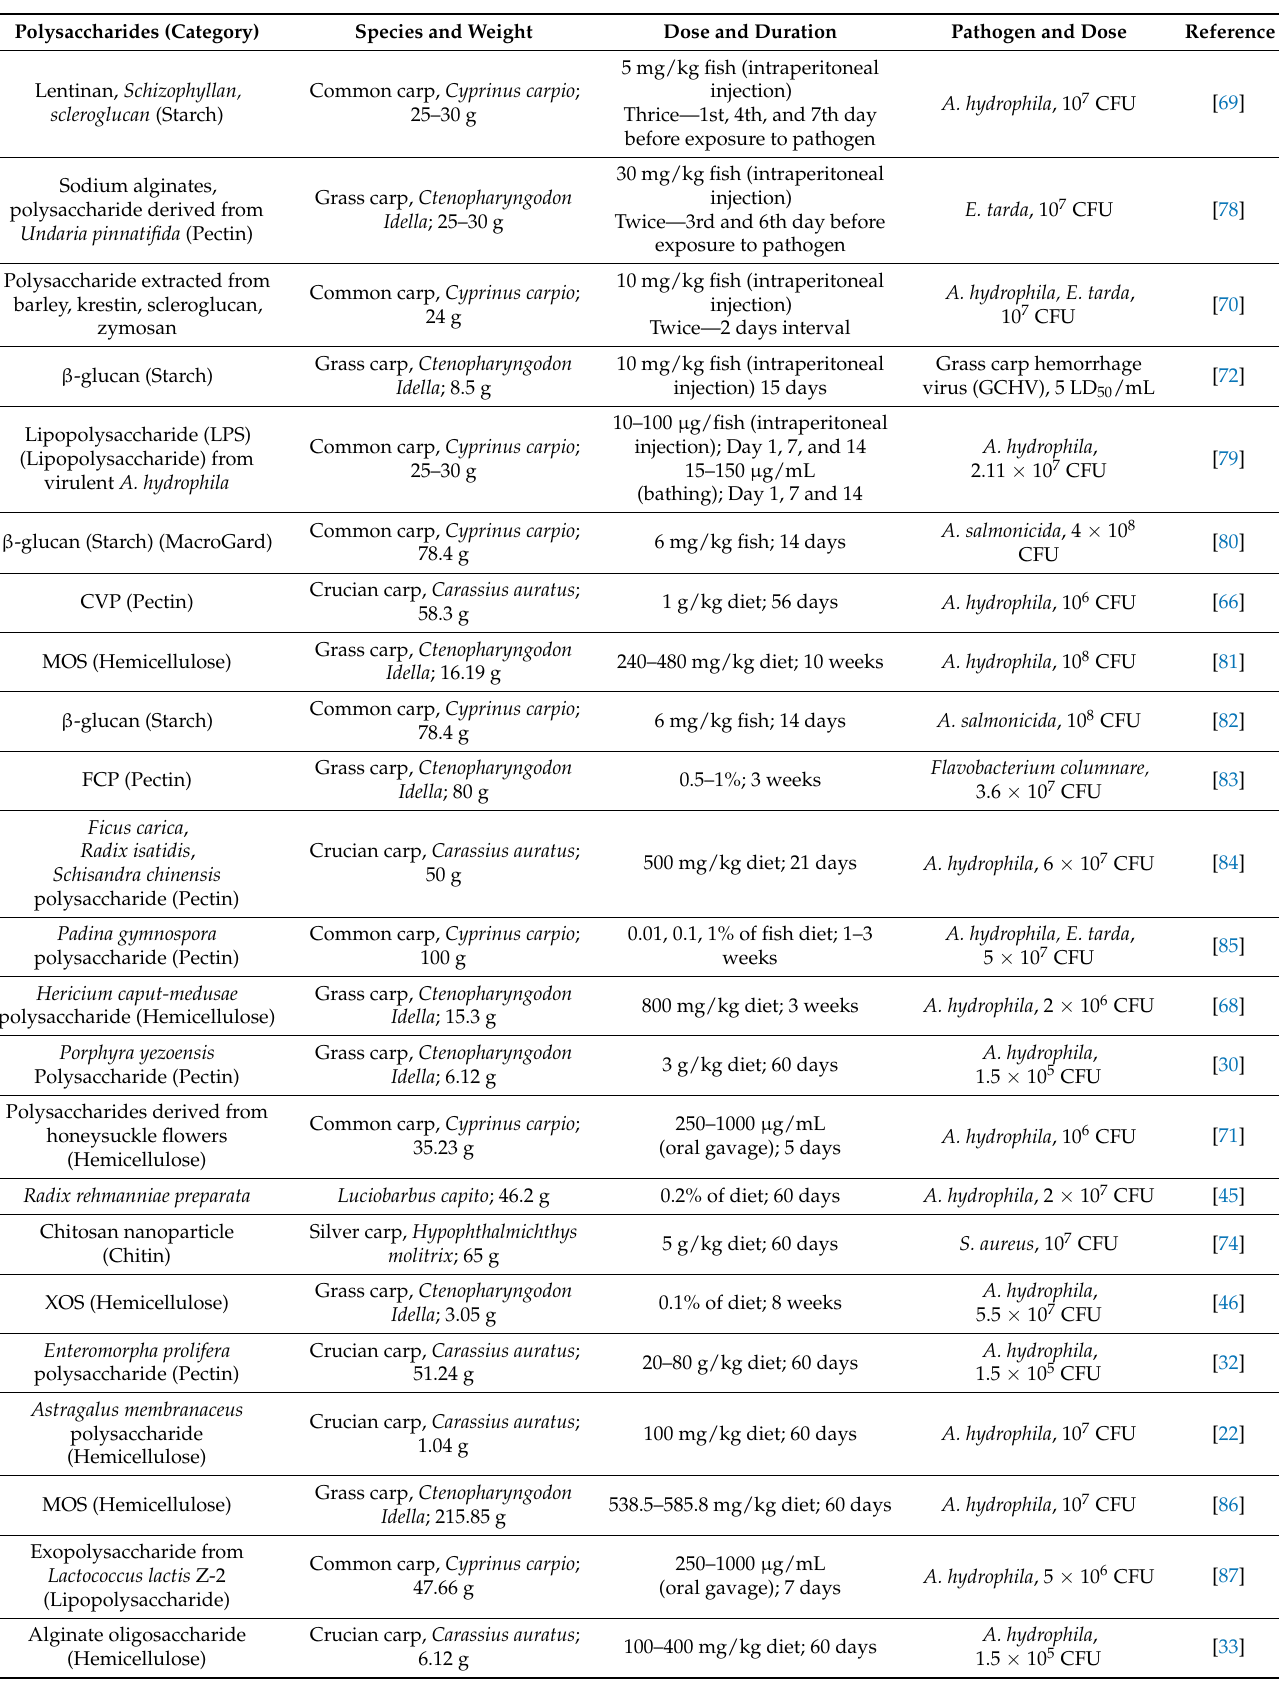
Table 3. Polysaccharides in enhancing diseases resistance of carp